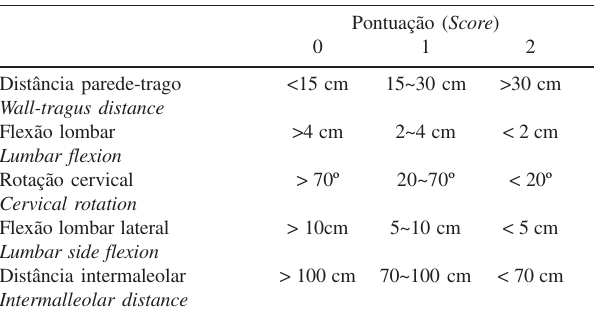
Table 2 - Questionnaire, The Bath Ankylosing Spondylitis Metrology, in the original version and in the version translated into the Brazilian-Portuguese language